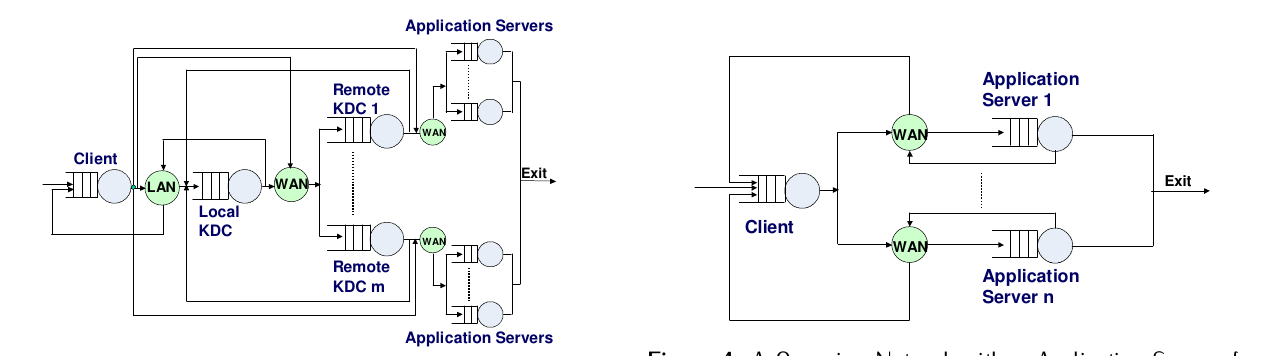
Figure 3. A Queueing Network with m Remote Realms for PKCROSS